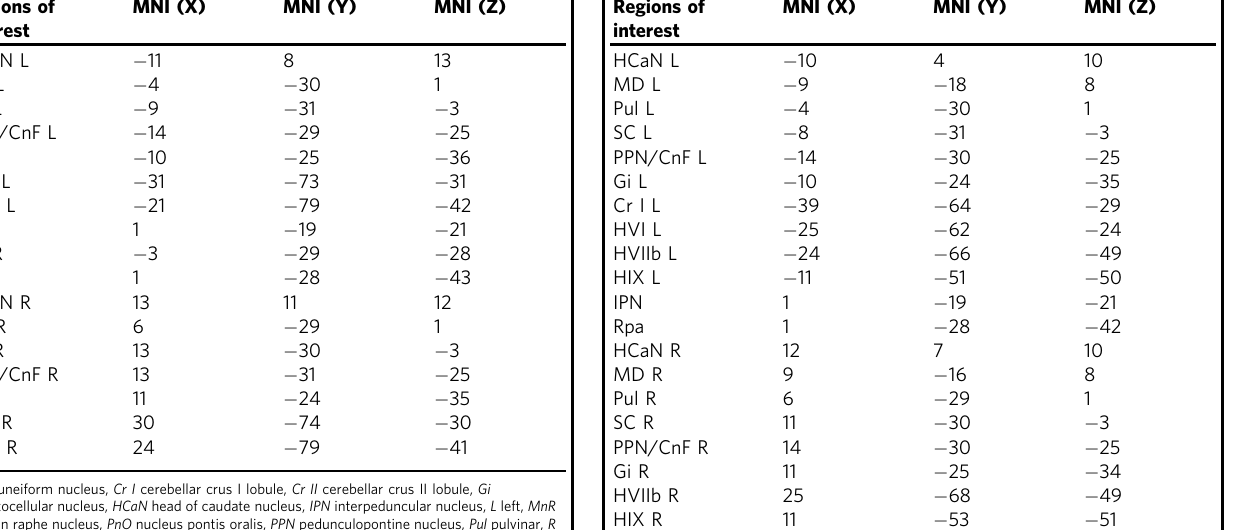
CnF cuneiform nucleus, Cr I cerebellar crus I lobule, Gi gigantocellular nucleus, HCaN head of caudate nucleus, HVI cerebellar lobule VI, HIX cerebellar lobule IX (cerebellar tonsils), IPN interpeduncular nucleus, L left, MD mediodorsal nucleusof the thalamus, PPN pedunculopontine nucleus, Pul pulvinar, R right, Rpa raphe pallidus nucleus, SC superior